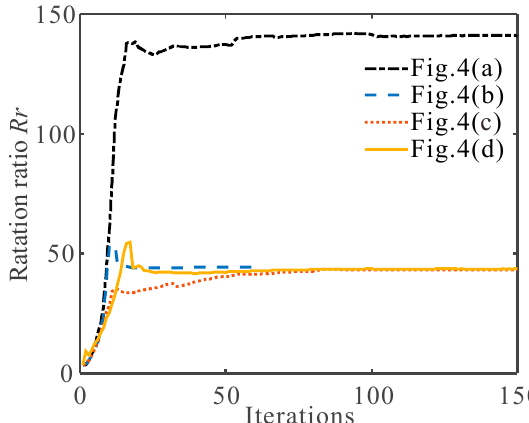
Figure 6. The convergence histories of the rotation ratio R r for the obtained flexure hinges described in Figure 4.